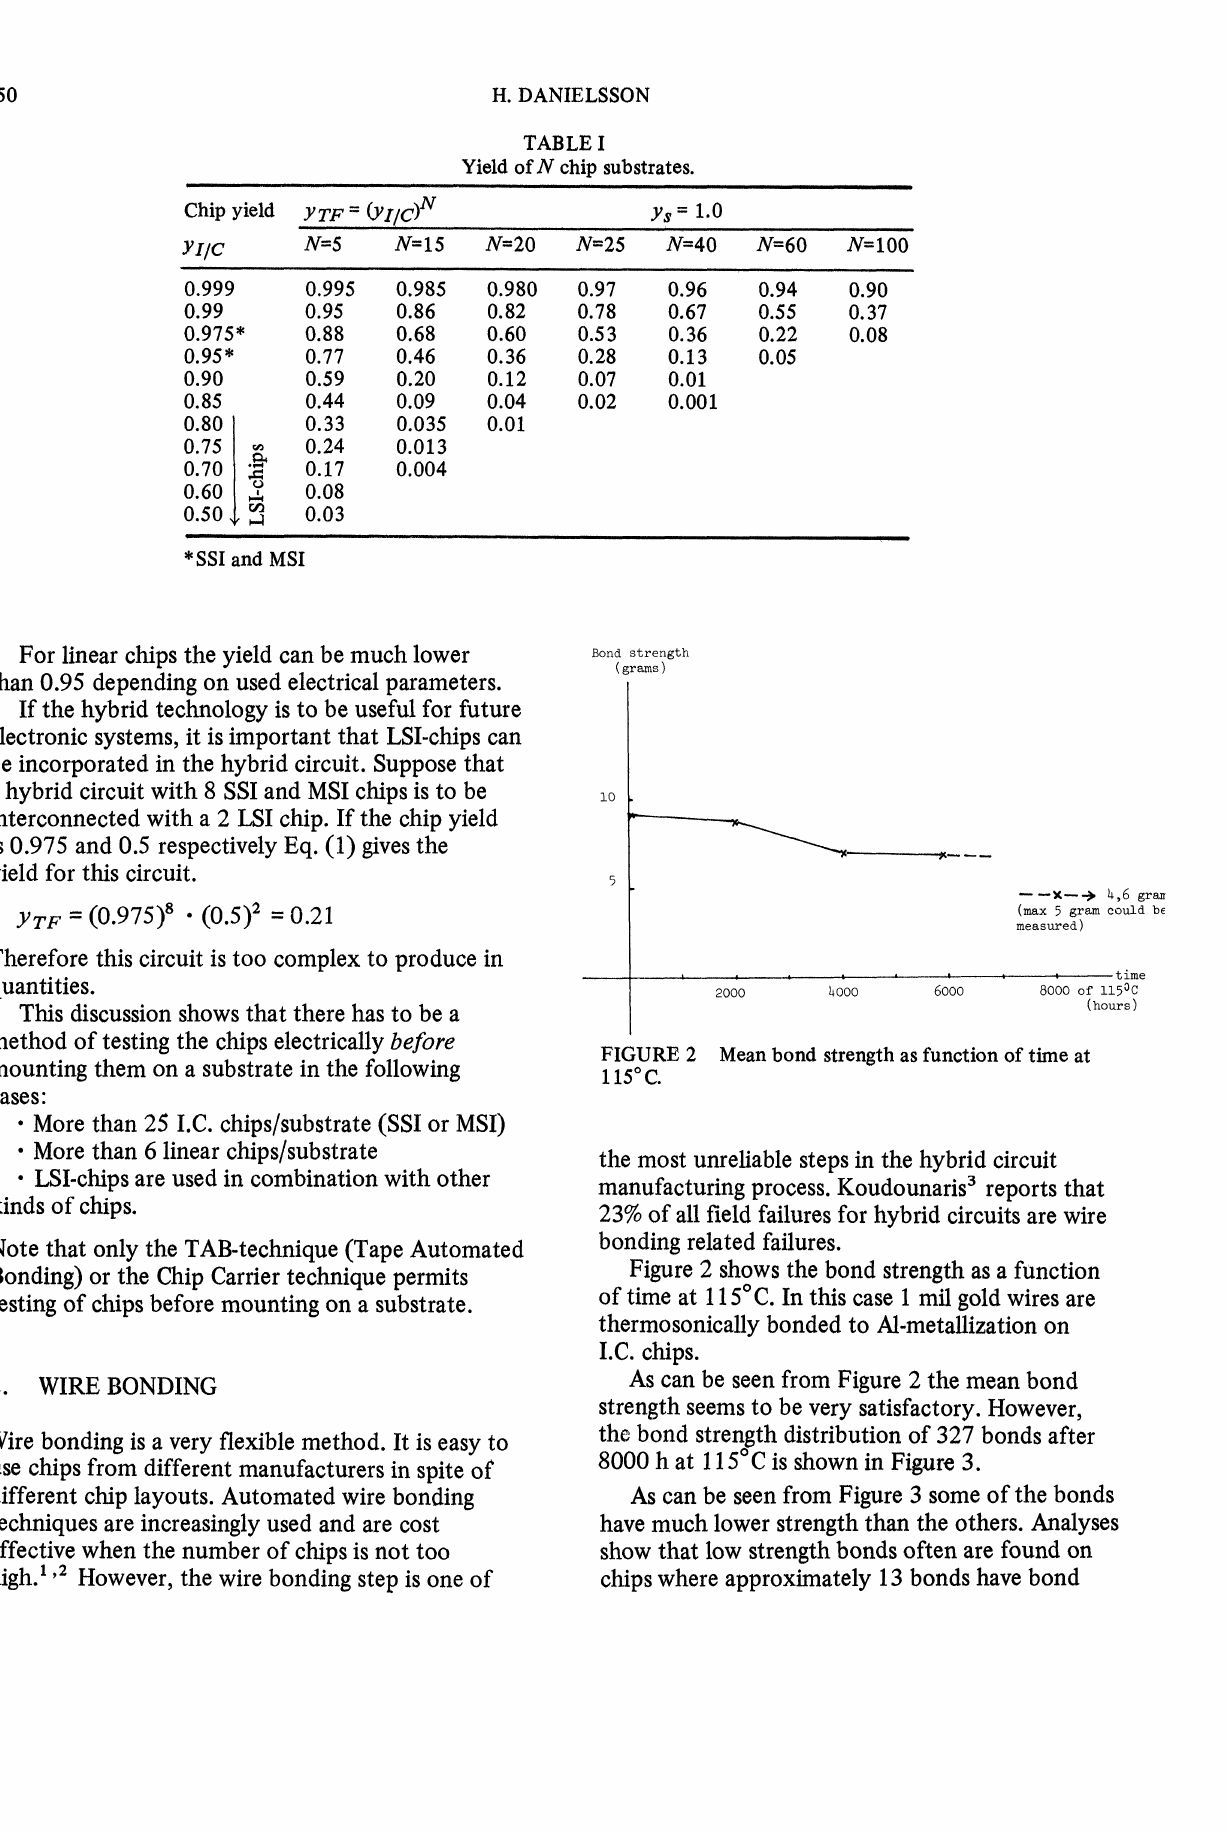
TABLE Yield of N chip substrates.